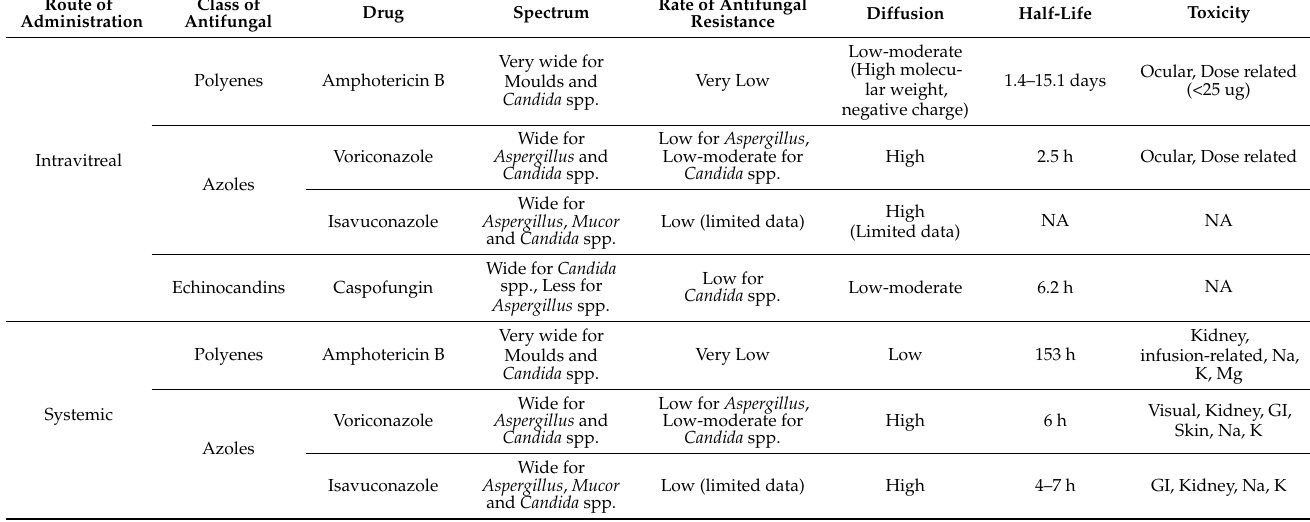
Table 1. Characteristics of main systemic and intravitreal antifungal drugs used for exogenous fungal endophthalmitis. Route of